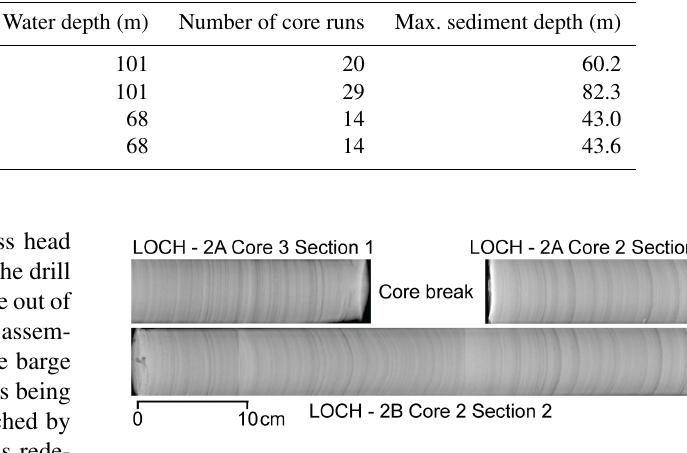
Figure 5. X-ray images showing 10cm core loss at run break in LOCH-2A and recovery of the missing section in offset hole LOCH-2B (up to right). Distinct layers can be correlated between cores at mm scale from each site using visual and statistical tech-